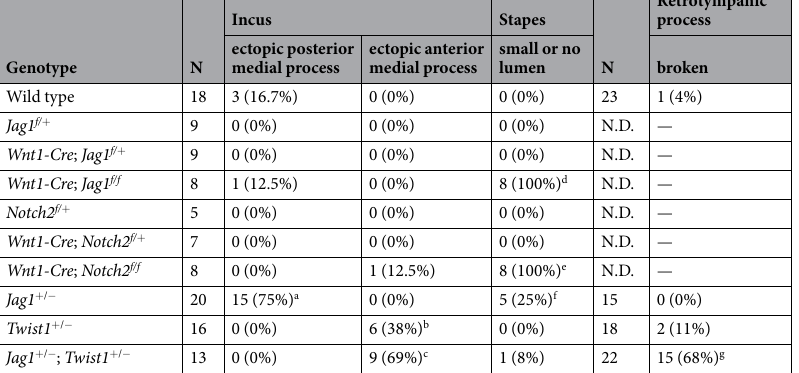
Wnt1-Cre ; Notch2 f/f